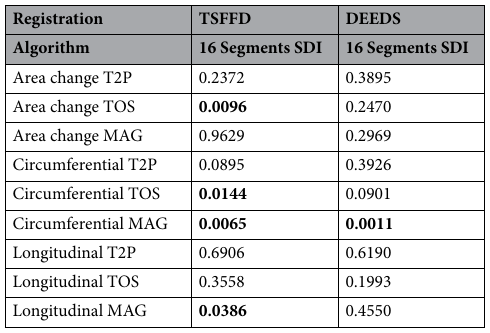
Table 2. Two-sample t -test using strains computed from TSFFD and DEEDS.